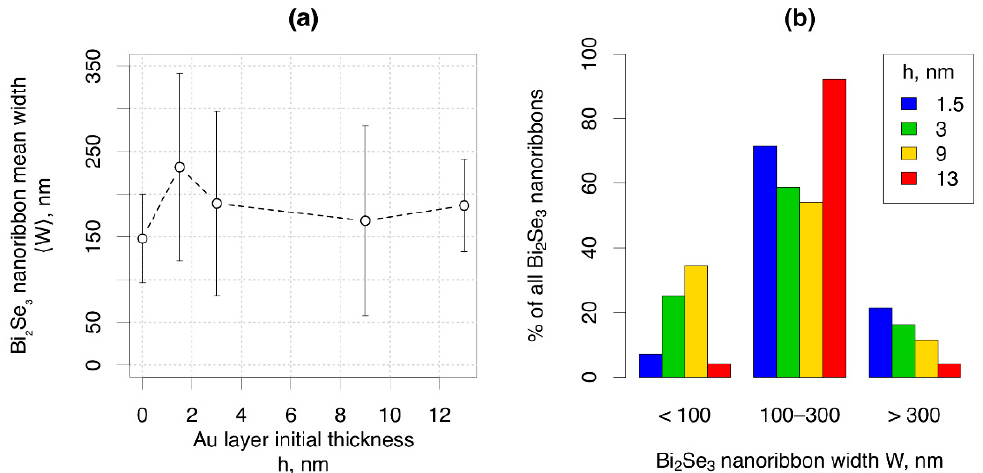
Figure 6. ( a ) Width distribution of Bi 2 Se 3 nanoribbons mechanically transferred from the dewetted Au layers of various thicknesses; ( b ) width distribution histogram.